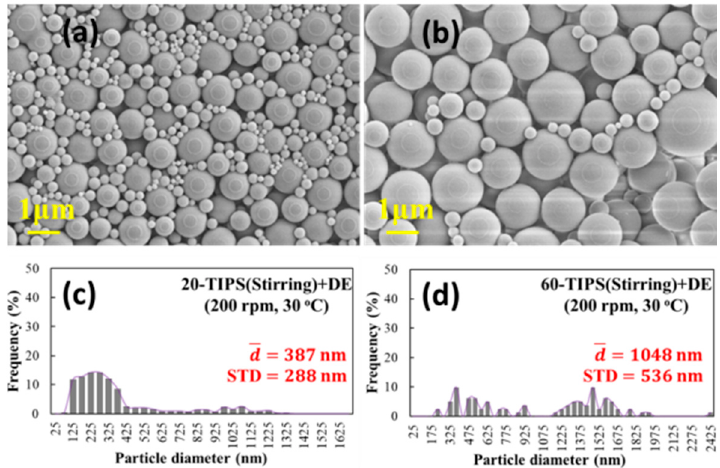
Figure 12. SEM observation of ( a ) 20-TIPS(Stirring) + DE samples and ( b ) 60-TIPS(Stirring) + DE samples; Particle size distribution of ( c ) 20-TIPS(Stirring) + DE samples and ( d ) 60-TIPS(Stirring) + DE samples.